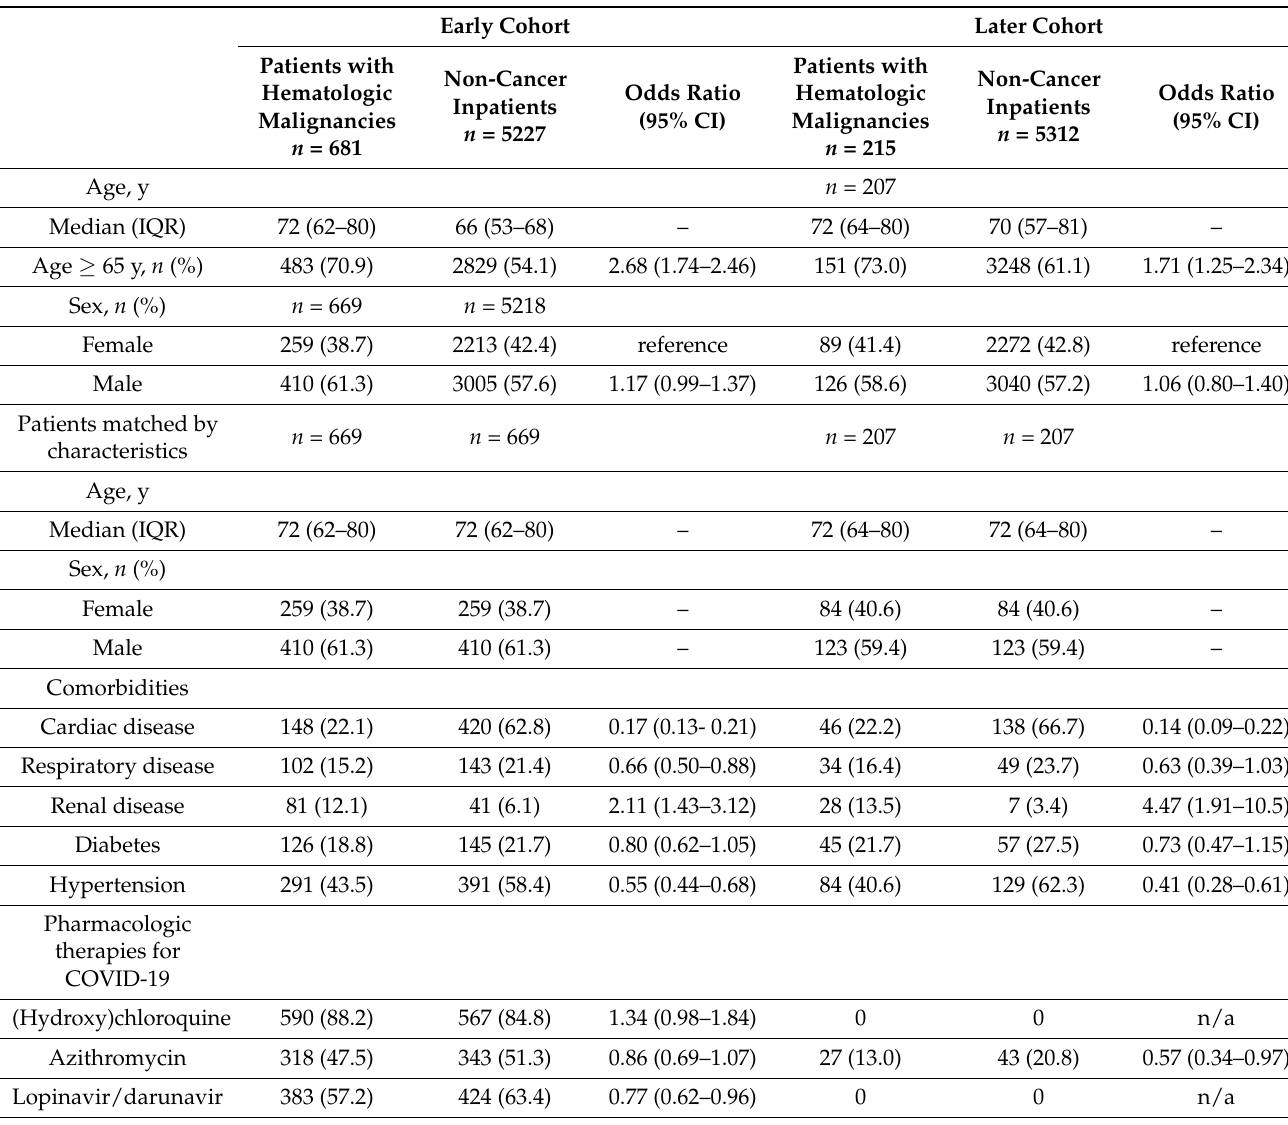
Table 4. Patients with hematologic malignancies vs. propensity-score-matched non-cancer inpatients according to time of